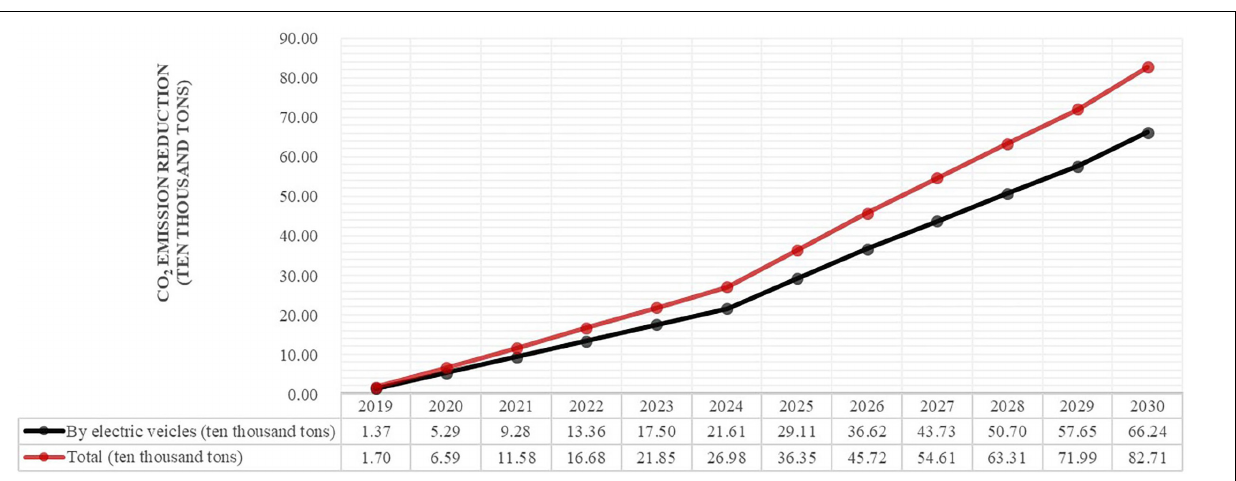
FIGURE 3 | The greenhouse gas emission